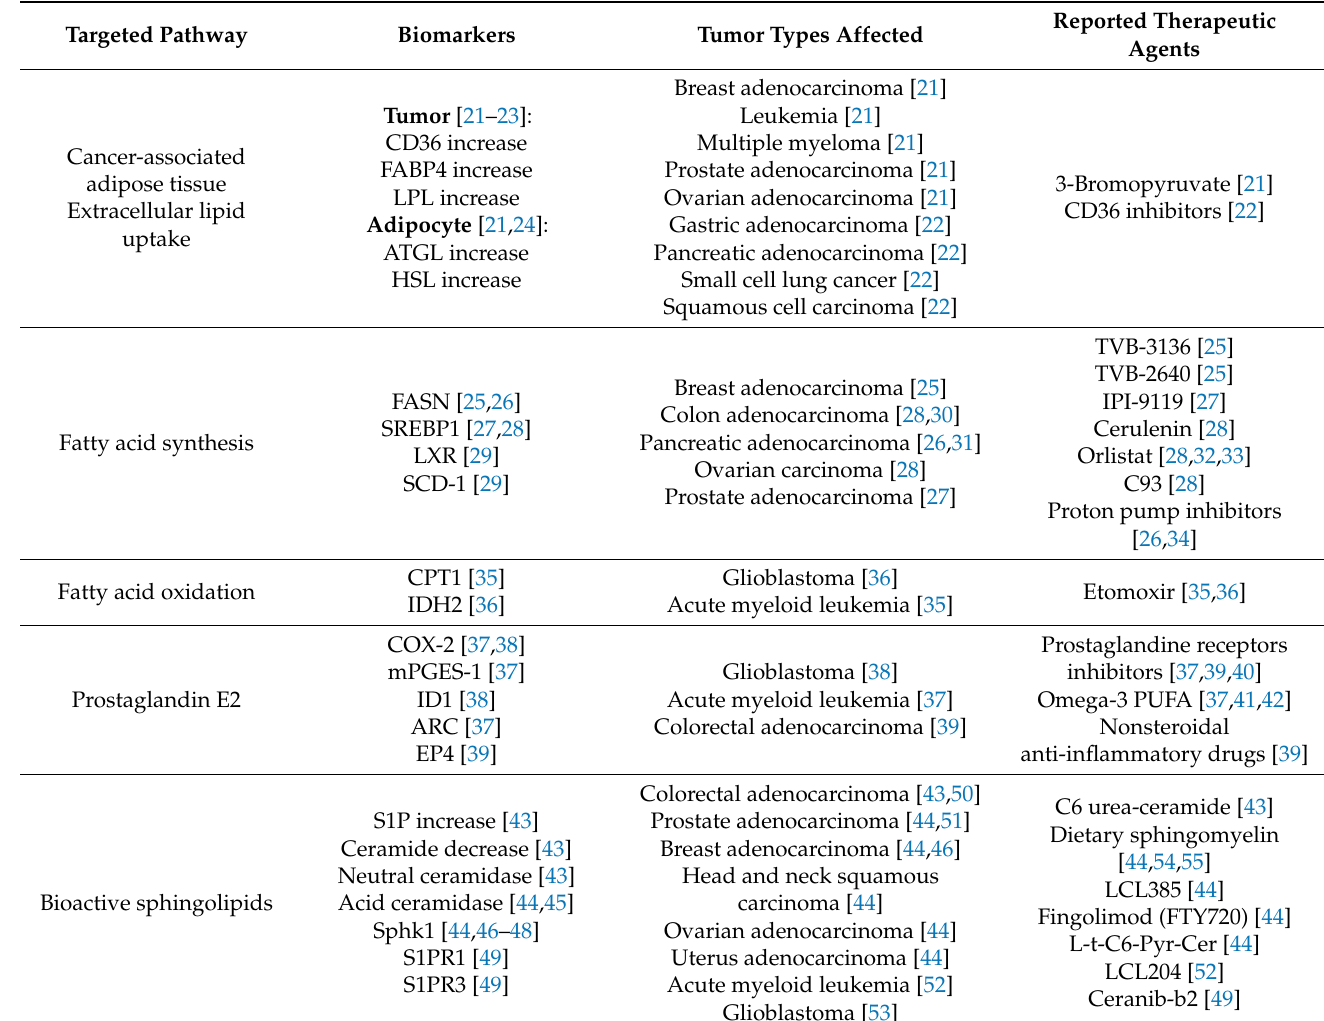
Table 1. Lipid metabolic alterations in